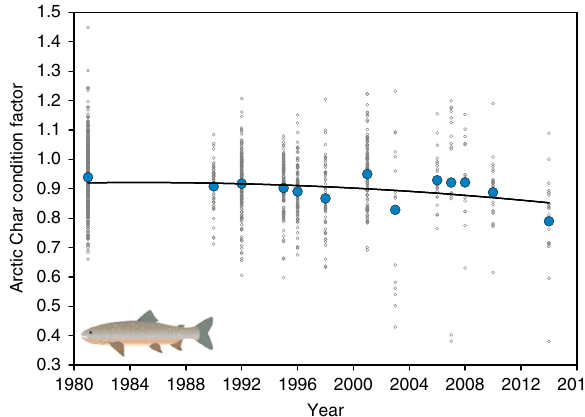
Fig. 6 Physiological condition of Arctic Char ( Salvelinus alpinus ) in Lake Hazen. Fulton ’ s condition factor was calculated for Arctic Char with a mass of 200 g or greater collected between 1981 and 2014. Small open circles are condition factors for individual Arctic Char, whereas larger blue circles are mean condition factors for a given year. A quadratic trend line was fi tted to all the data ( p < 0.001). Arctic Char image credit: Kativik